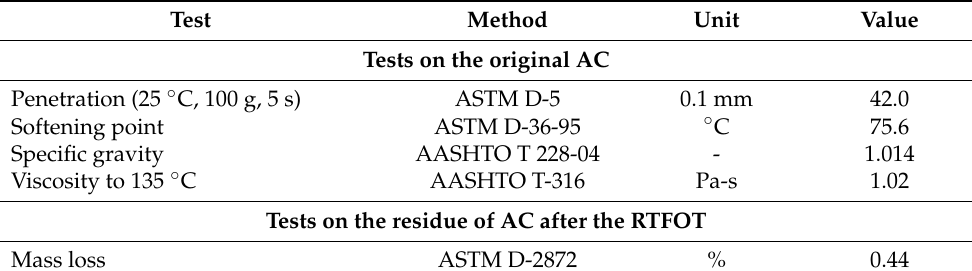
Table 3. Properties of